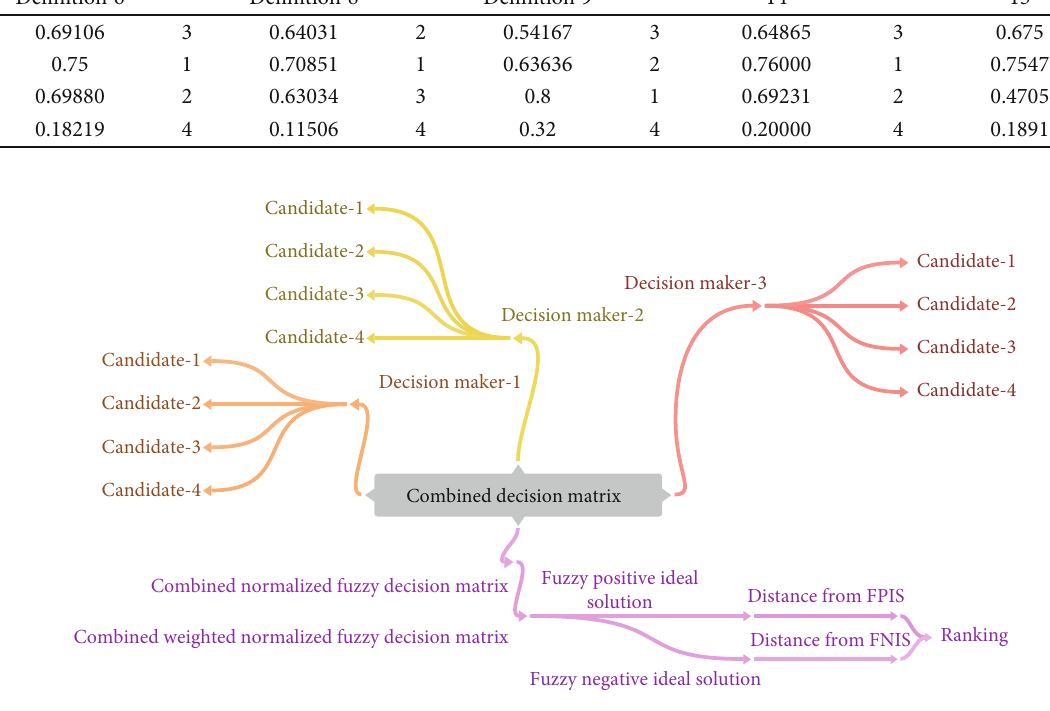
Figure 3: Flow chart of algorithm for decision-making.